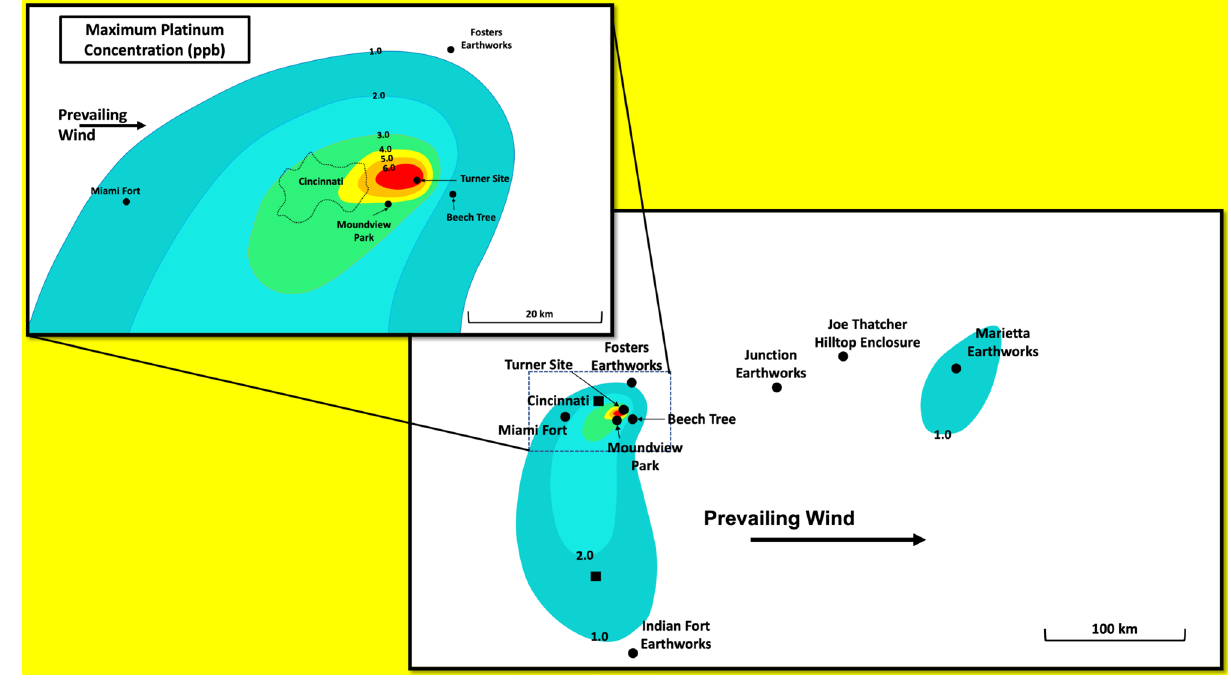
Figure 22. Geographic distribution of a positive platinum anomaly. Stephen Meyers and Stephanie Meyers used Microsoft PowerPoint for Mac Version 16.41 (www. micro soft. com) to create this figure.